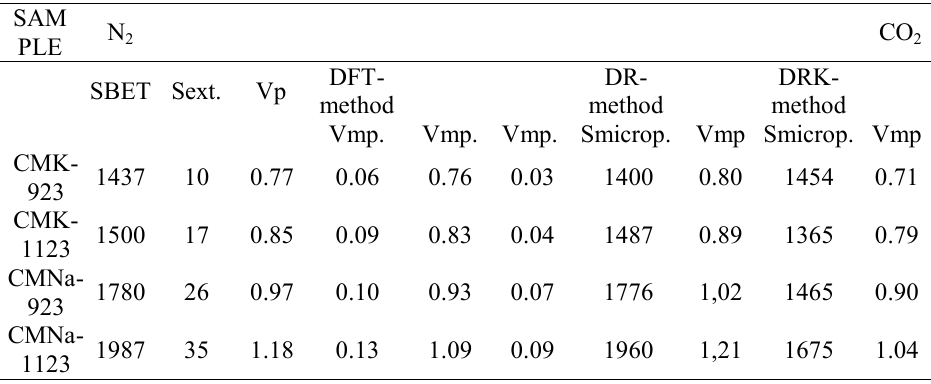
Table 1. Textural parameters deduced from N 273 K on ACs prepared at different temperatures and different